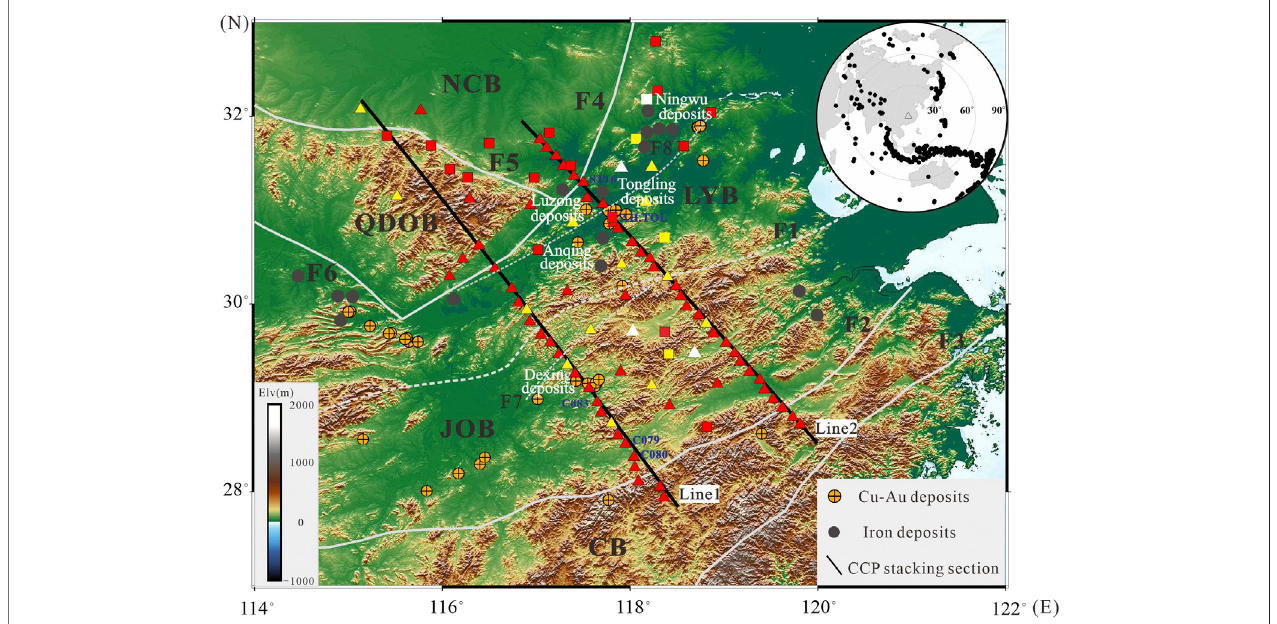
FIGURE 1 | Seismic stations and teleseismic event locations (upper right corner) in the study area. The background color maps indicate the topography (unit: m). The triangles represent the temporary stations, squares represent the permanent stations, yellow triangles and squares denote stations without harmonic corrections, andwhitetrianglesandsquaresindicateabandonedstations.NCB,NorthChinaBlock;LYB,LowerYangtzeBlock;JOB,JiangnanOrogenicBelt;QDOB,Qinling-Dabie Orogenic Belt; CB, Cathaysia Block; F1, Jiangnan Buried Fault; F2, Jiangshao Fault; F3, Zhenghe-Dapu Fault; F4, Tanlu Fault; F5, Xinyang-Shucheng Fault; F6, Xiangfan-Guangji Fault; F7, northeast Jiangxi Fault; F8, YangtzeRiver Deep Fault. Showing locations of major Cue-Au and Iron deposits. The black lines are the position oftheresearchpro fi les (Line1and Line2used in Figure7 ),and thetriangleand black dots intheupper rightcorner indicate thecenter ofthestudy areaand teleseismic events, respectively. Main structural lines and fault lines are described in (Shu et al., 2013) and (Lü et al., 2015, Lü et al., 2021).